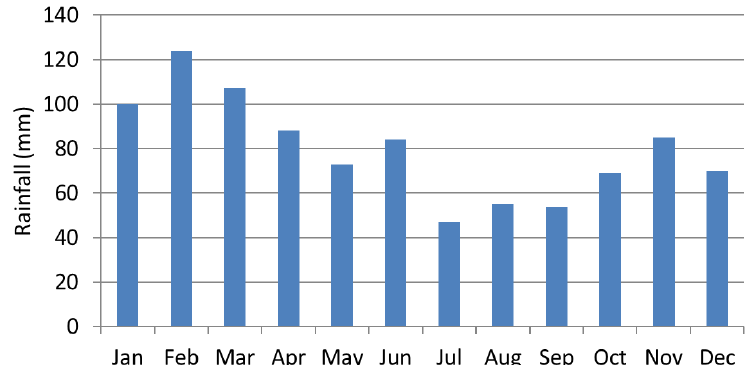
Figure 2. Average monthly rainfall in the Greater Sydney